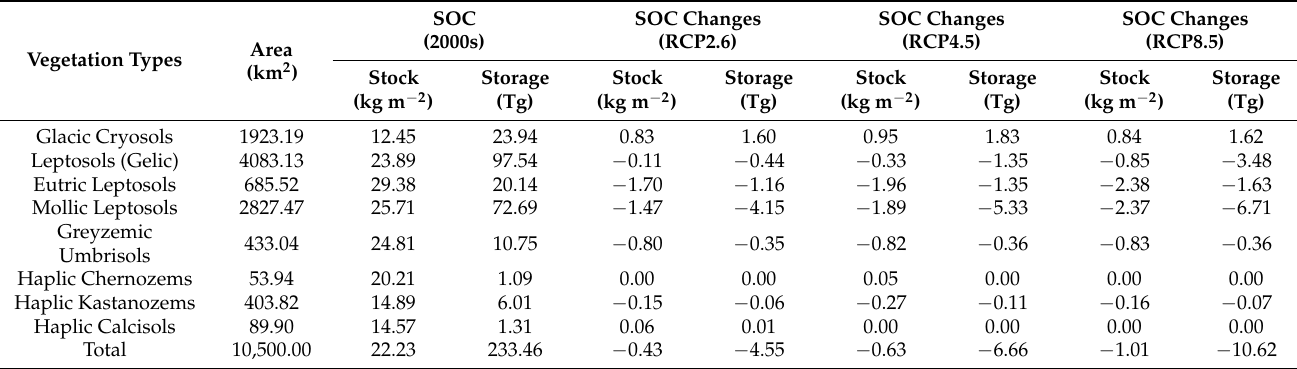
Table 5. Summary of SOC stocks and storage changes by soil types under different climate change scenarios from the 2000s to the